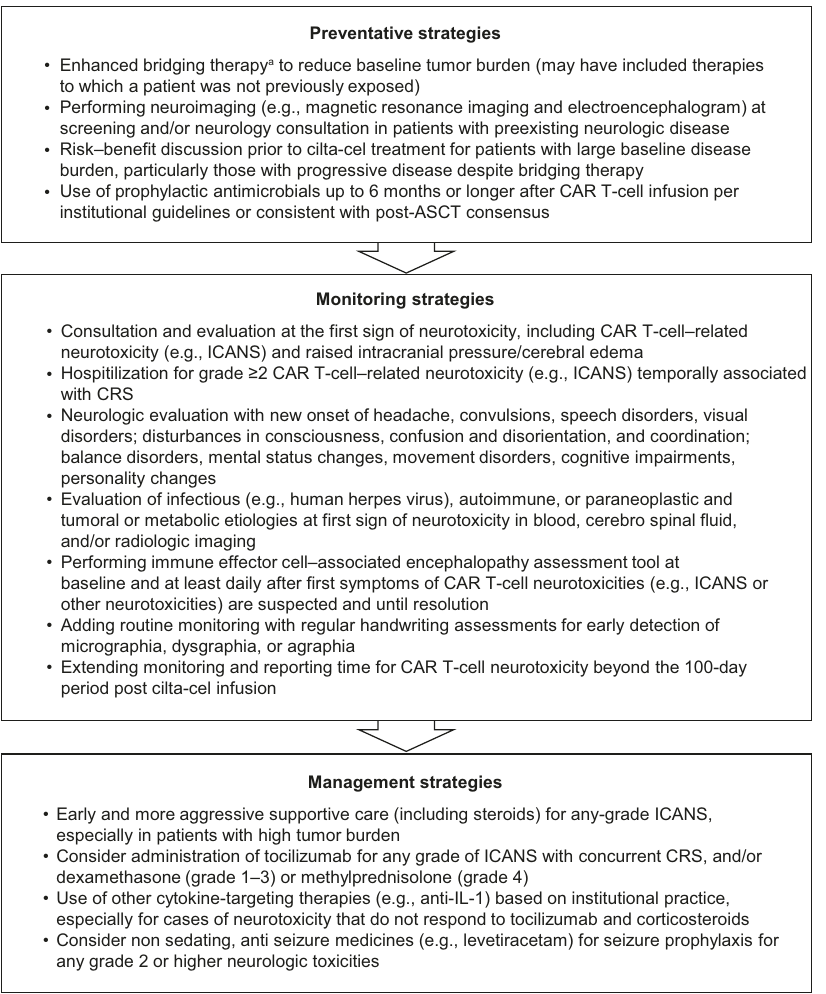
Fig. 5 Patient-management strategies for neurologic adverse events following treatment with cilta-cel. a Fewer restrictions (per protocol) on the investigator ’ s choice of bridging therapy, including its duration, to reduce baseline tumor burden before cilta-cel infusion. ASTCT American Society for Transplantation and Cellular Therapy, CAR chimeric antigen receptor, CRS cytokine release syndrome, ICANS immune effector cell-associated neurotoxicity syndrome, IL